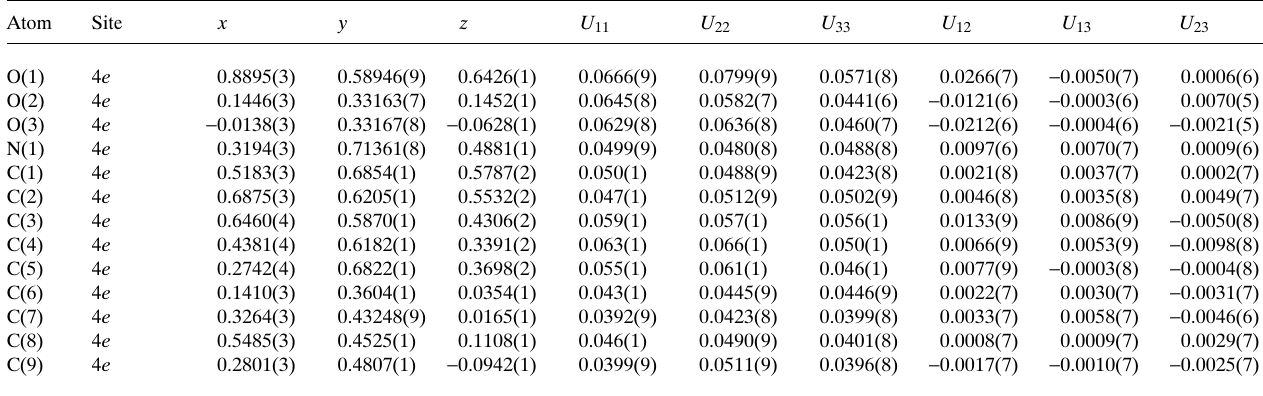
Table 3. Atomic coordinates and displacement parameters (in Å 2 ) .